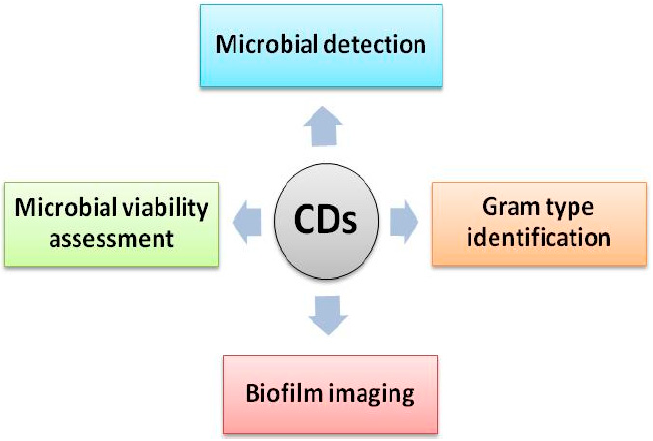
Figure 1. Carbon dots (CDs) for sensing microorganisms.